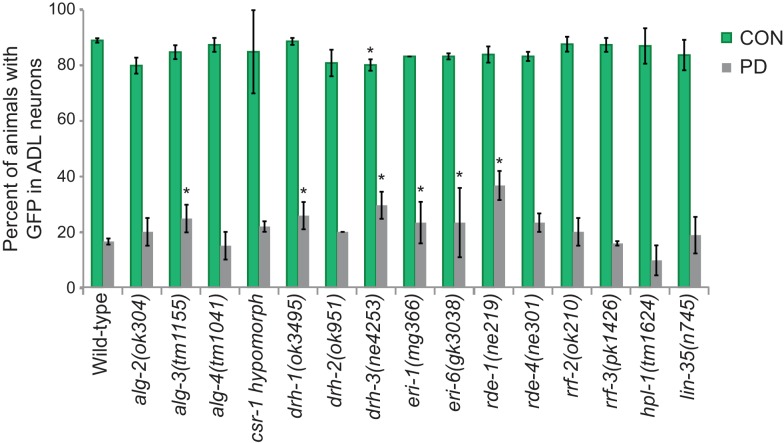
The ERGO-1/NRDE-3 endo-siRNA pathway contributes to the developmental programming of osm-9 gene expression.Percentage of CON and PD adults that exhibited GFP in ADL neurons in additional mutant strains with functions in endo-RNAi and chromatin remodeling is shown. * indicates CON or PD significantly different compared to wildtype; p<0.05; One-way ANOVA with LSD posthoc correction. N ≥ 2 trials; n ≥ 40 animals. Error bars represent S.E.M. (Figure 4—figure supplement 1—source data 1).DOI:
http://dx.doi.org/10.7554/eLife.11642.02810.7554/eLife.11642.029Figure 4—figure supplement 1—source data 1.Spreadsheet containing percentage of animals expressing osm-9p::gfp in ADL neurons of additional strains carrying mutations in genes with RNAi and chromatin remodeling functions.